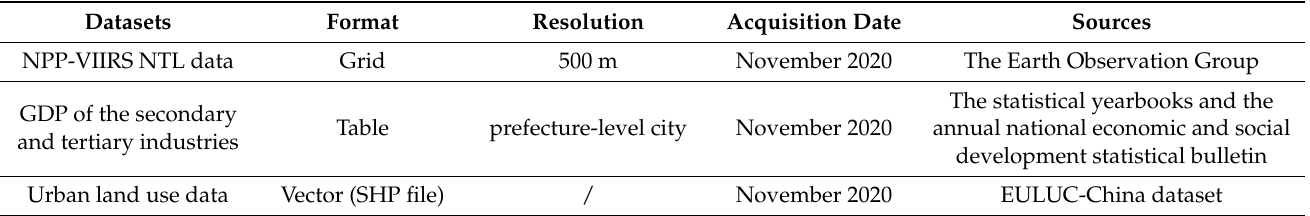
Table 1. List of the datasets and sources used in this